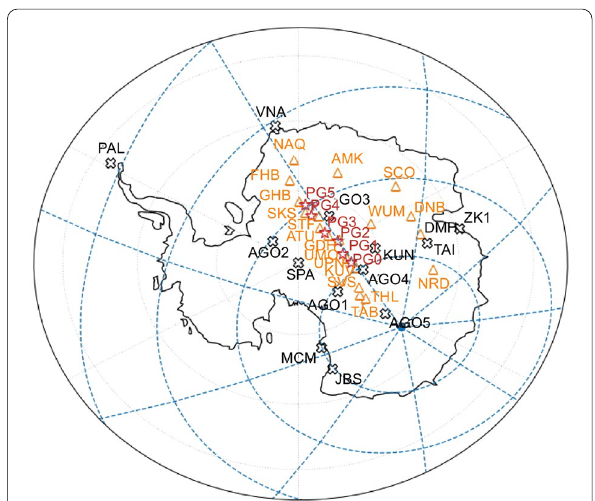
Fig. 1 Antarctic 40° magnetic meridian chain (AAL-PIP stations are shown in